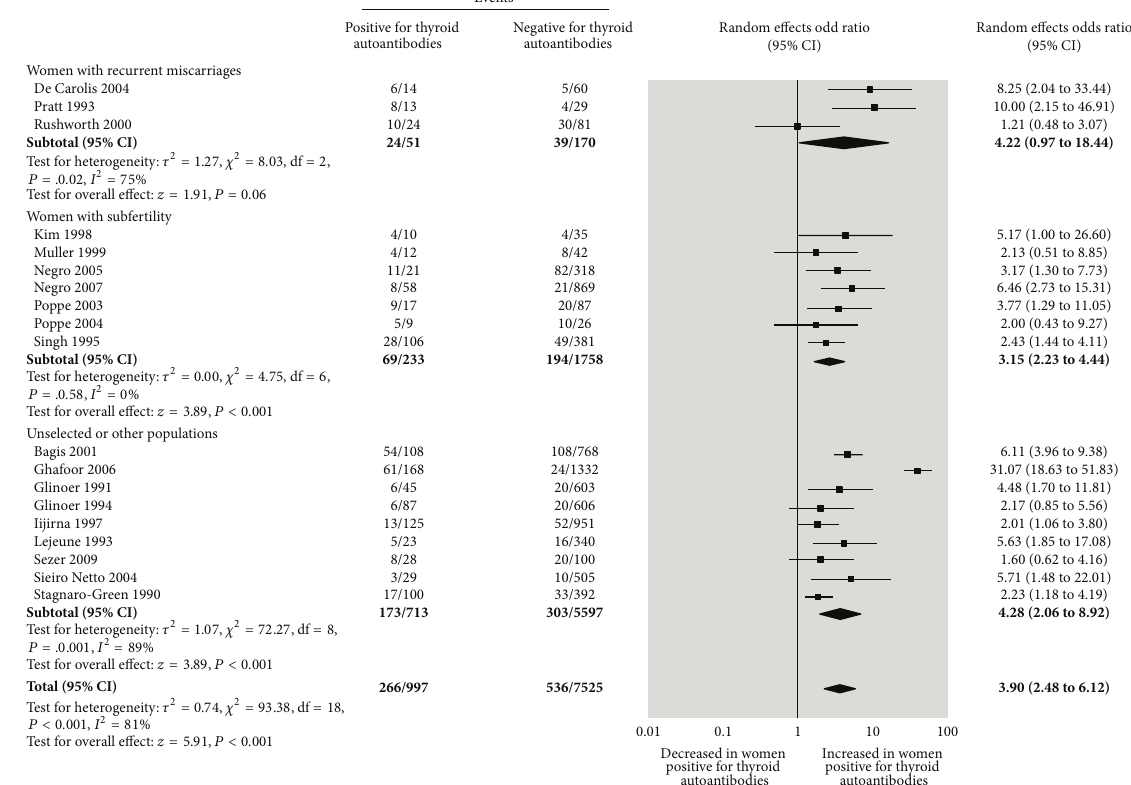
Figure 3: Relationship between thyroid antibodies and Miscarriages. The association of thyroid autoantibodies and miscarriages in multiple cohort studies is shown in meta-analysis by Thangaratinam et al. 2011 [85]. There is an increased prevalence of women positive for thyroid autoantibodies in individuals with subfertility and with recurrent